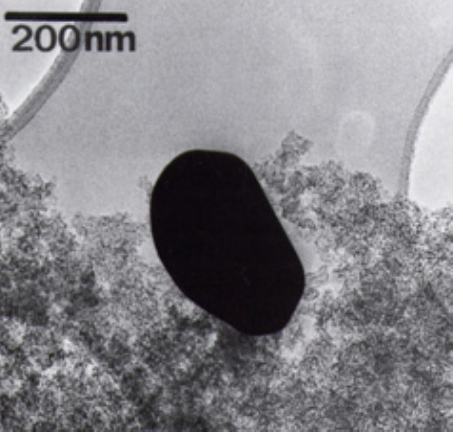
Figure 1. TEM image of Au/AC prepared by impregnation